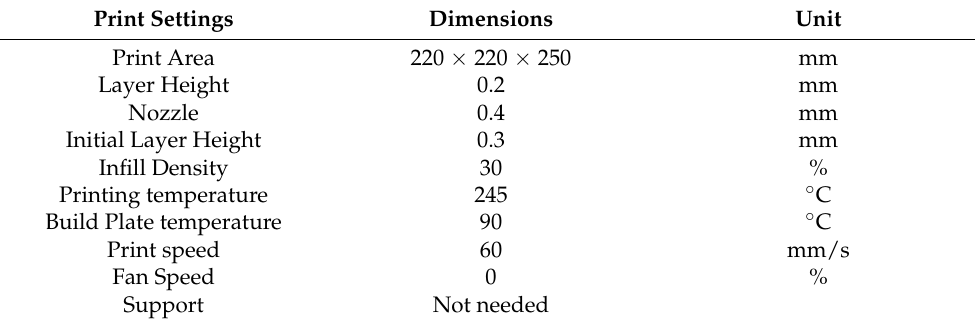
Table 1. Print settings for the FDM manufacturing of the proposed heliostatic illuminator. Print Settings Dimensions Unit Print Area 220 × 220 × 250